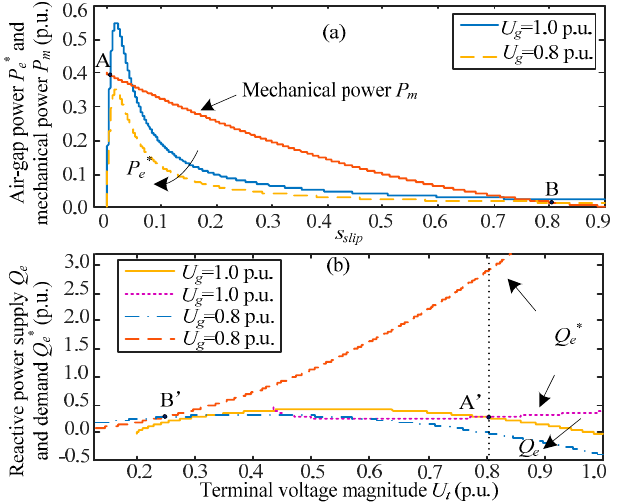
Figure 9. Abnormally low voltage analysis: ( a ) air-gap power P e * and mechanical power P m versus slip curves; ( b ) reactive power supply Q e and reactive power demand Q e * versus terminal voltage magnitude U t curves.